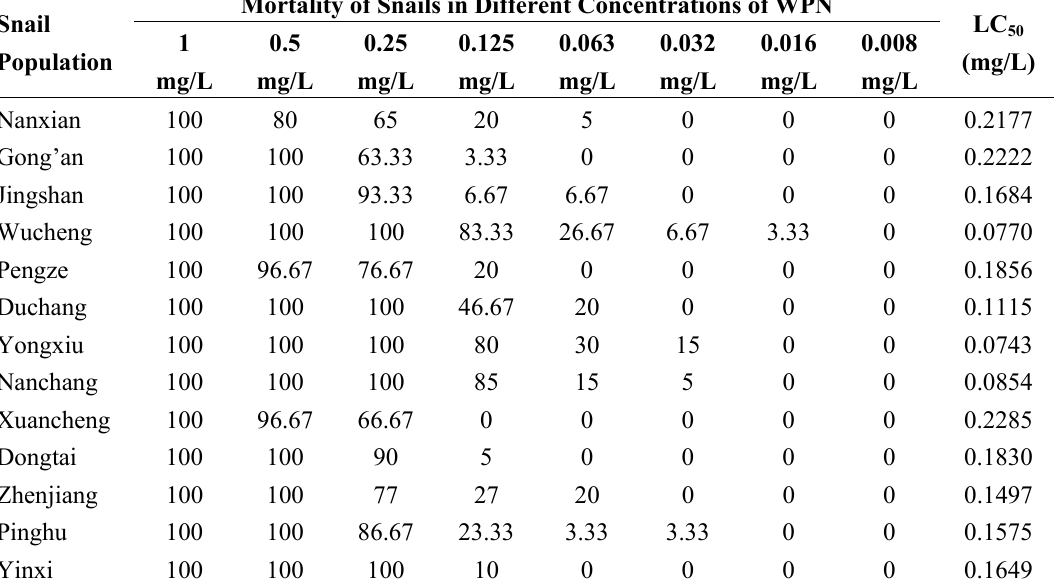
values of Oncomelania hupensis snails 50